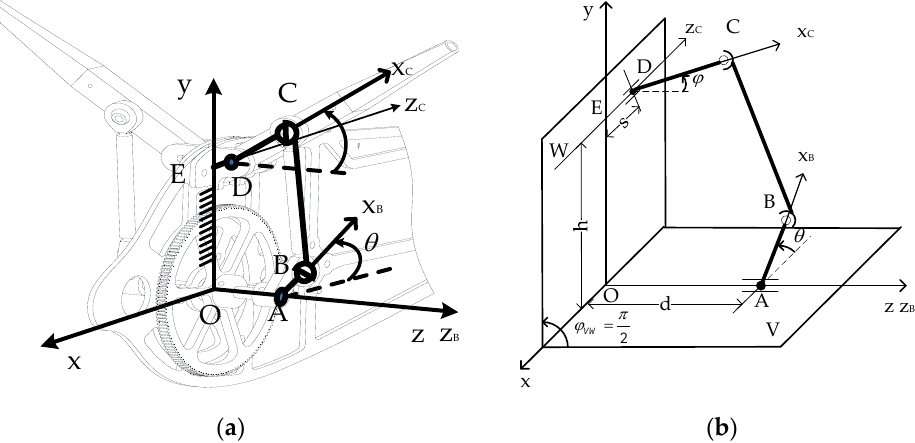
Figure 2. ( a ) The drive unit mechanism schematic and ( b ) sketch of the RSSR space four-link mechanism. The flapping motion of birds can be divided into up-and-down flapping, forward and backward swinging, twisting around the spanwise, and folding of the wing surface during upward flapping. During forward flight, forward and backward swinging and folding of the wing are ignored in this work.